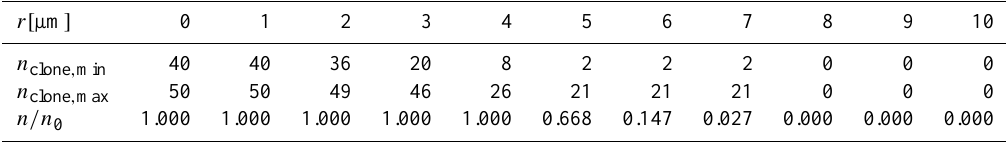
Table 1. Minimum and maximum number of particle clones ( n clone , min , n clone , max ) among the n 0 particles remaining in the atmosphere for particle radius r . n denotes the number of particles having at least two clones remaining in the atmosphere over 2 . 5 days.